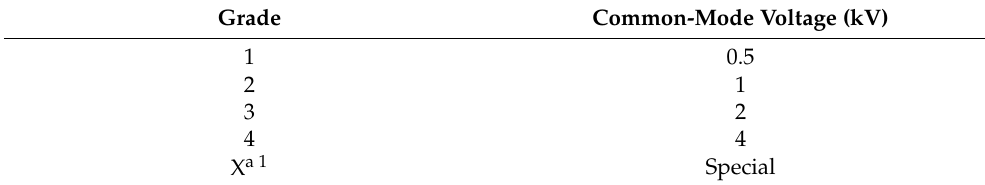
Table 4. Fast damping oscillating wave test level.